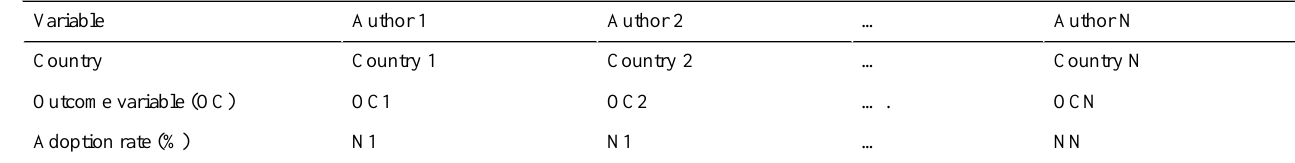
Table 3. Percentage of participants in each study that were willing to adopt contact tracing